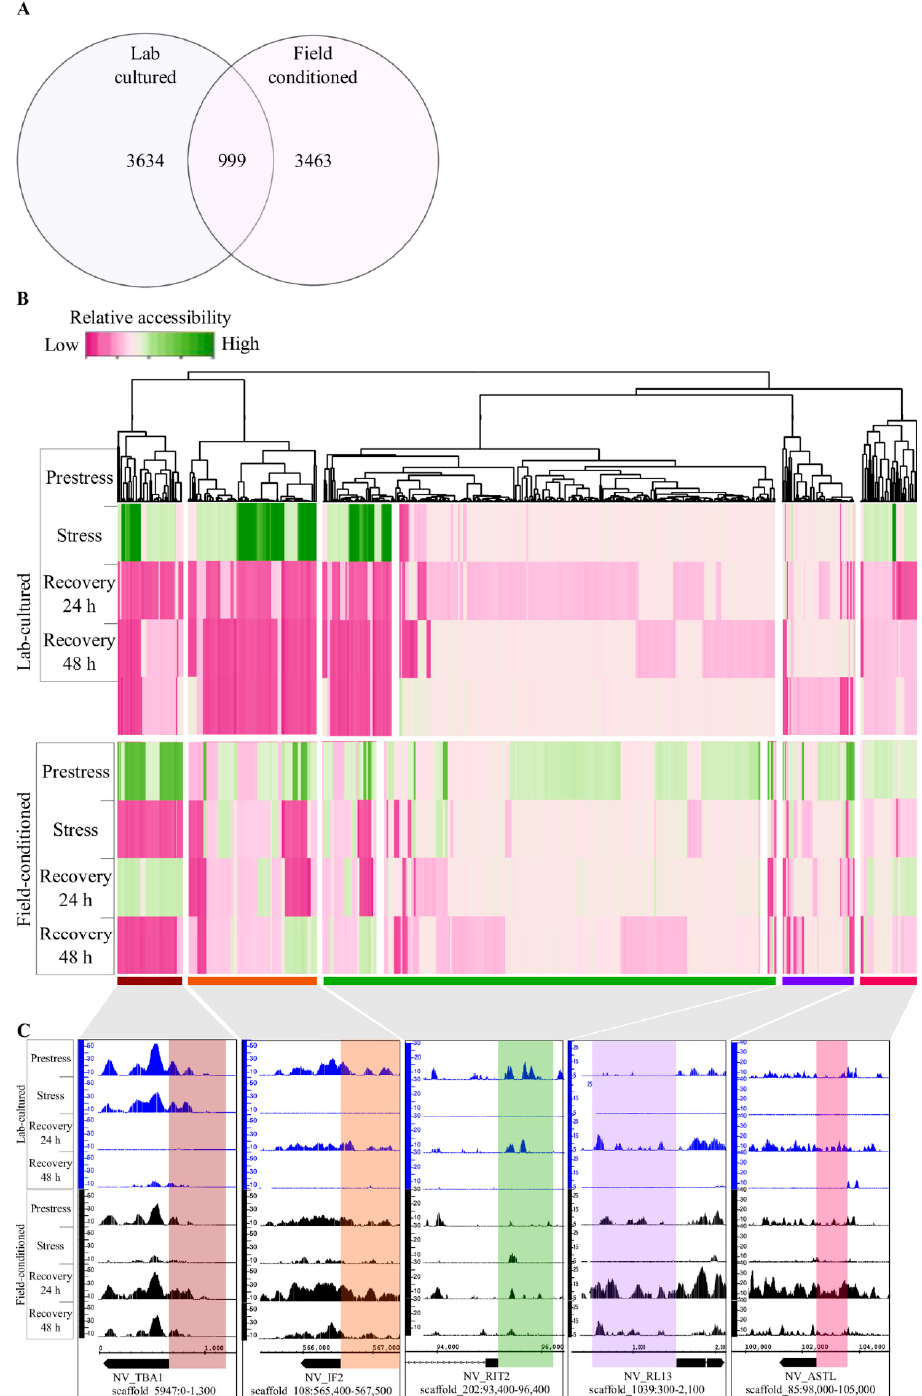
Figure 4. Changes in DNA regulatory landscape in response to heat exposure. ( A ) Venn diagram of 4462 differentially accessible promoters in the field-conditioned group (purple), and 4633 differentially accessible promoters in the lab-cultured N. vectensis . ( B ) Heatmap of 999 ATAC-seq promoter sites found in both groups as identified for each thermal treatment were clustered, yielding five accessibility clusters: cluster (1)—brown, cluster (2)—orange, cluster (3)—green, cluster (4)—purple, and cluster (5)—pink. Each column represents one gene in lab-cultured (top) and field-conditioned (bottom) groups. ( C ) Representative examples of genes from each accessibility cluster—blue peaks represent lab-cultured ATAC-seq peaks, and black peaks represent field-conditioned ATAC-seq peaks. Specific coordinates are shown below tracks; sites of interest are highlighted in a similar color representing the 1000 bp promoter region of each